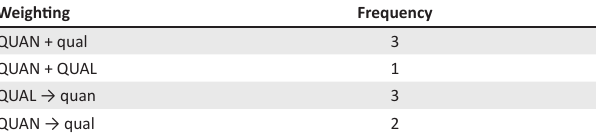
TABLE 3: Weighting of the quantitative and qualitative strands. Weighting